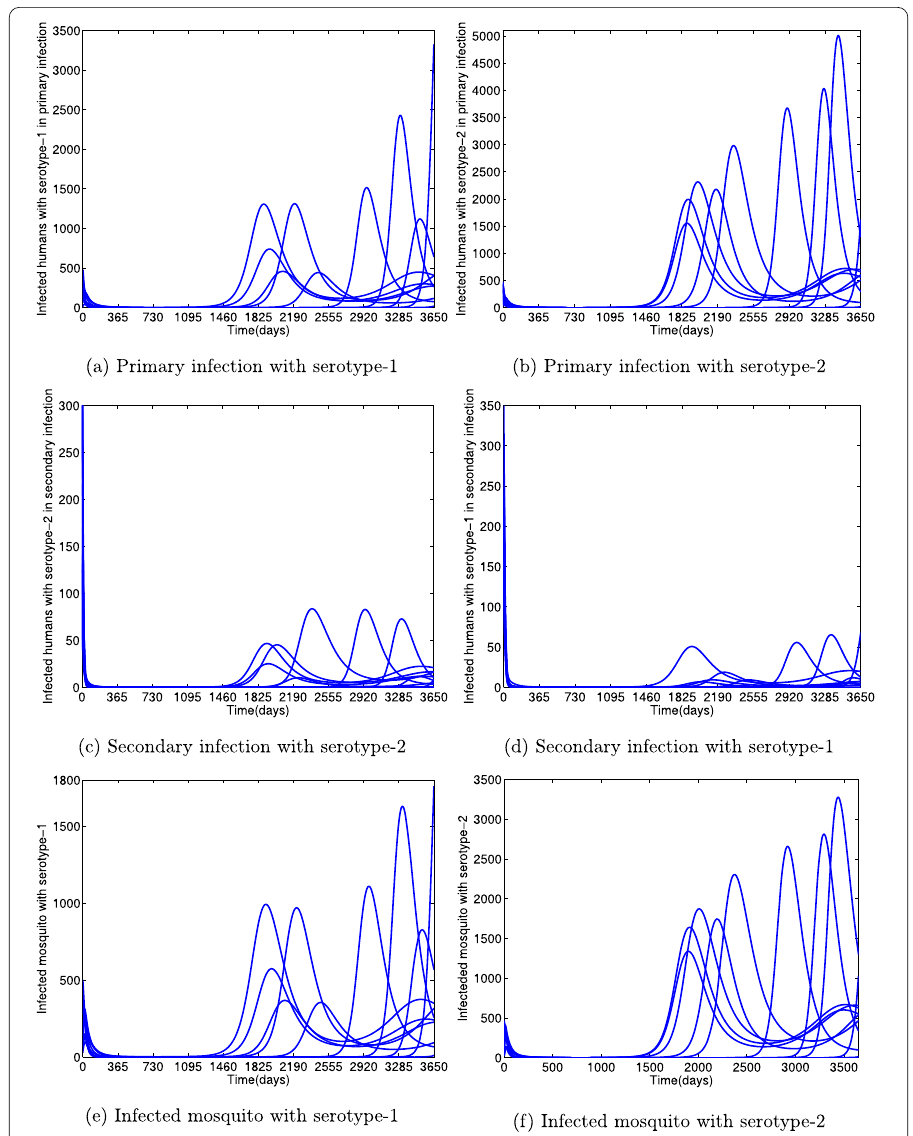
Figure 7 Time series plots of the number of infected humans and mosquitoes predicted by the multi-serotype dengue model (2.4)–(2.5) with different initial sizes of the sub-populations. The values of model parameters used are given in Table 2 and λ = 0.0111 which corresponds to cross immunity lasting as long as three months after primary experience infection